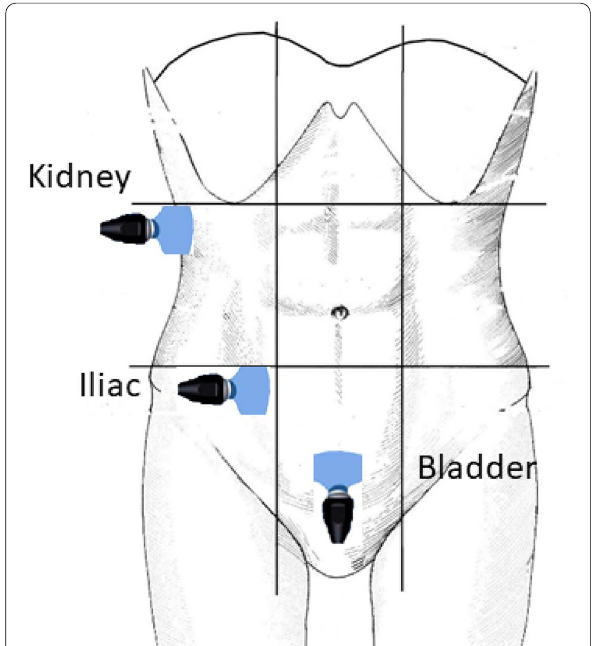
Fig. 1 Successive probe positions to explore urinary